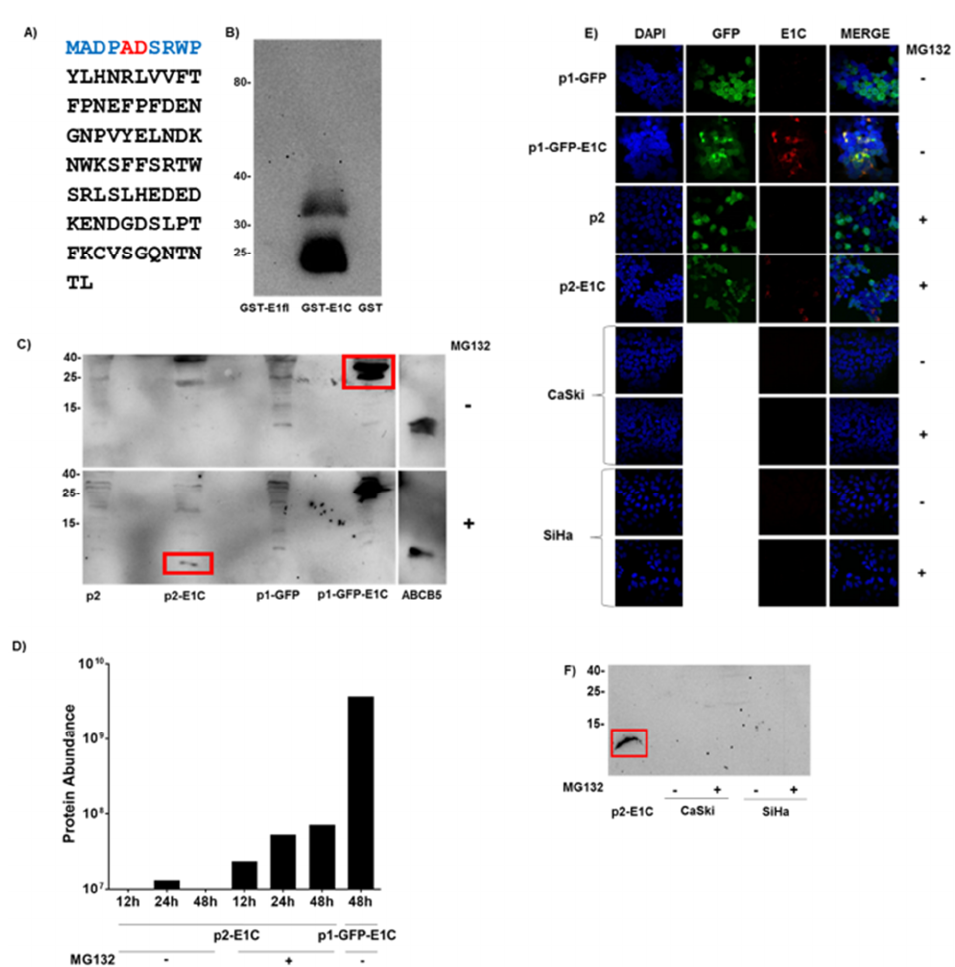
Figure 1. Detection of E1C protein. ( A ) Sequence of the putative E1C protein in black showing the 10 aa E1C-specific peptide used for mouse immunization in blue and the splice junction-derived peptide fusion ‘AD’ in red. ( B ) Reactivity of E1C mAb (hybridoma sub-clone 61/1/2) in Western blot with E. coli lysates overexpressing GST, GST-E1C and GST-E1 full-length (fl) fusion proteins. ( C ) E1C mAb-stained Western blot of lysates (100 µg total protein, prepared 48 h post transfection) from HEK-293T cells transfected with expression plasmids p2, p2-E1C, p1-GFP or p1-GFP-E1C with (bottom) or without (top) proteasome inhibitor MG132 treatment. Size marker (in kDa) is shown on the left and 50 ng of truncated ATP-Binding Cassette sub-family B member 5 (ABCB5)-6XHis protein as positive control for detection of very small pro- teins on the right. Expected positions of E1C and GFP-E1C proteins are marked by red boxes. See supplementary infor- mation (Figure S3) for 12 h and 24 h post transfection results. ( D ) Mass spectrometry analysis of trypsin-digested lysates from HEK-293T cells transfected with p2-E1C or p1-GFP-E1C, harvested 12, 24 and 48 h post transfection with or without MG132 treatment. Y-axis (log 10 scale) shows the combined abundance (protein abundance) of four HPV16 E1C peptides. ( E ) Immunofluorescence reactivity of E1C mAb (hybridoma sub-clone 61/1/2) in HEK-293T cells transfected with p1-GFP or p1-GFP-E1C and E1C immunofluorescence of HEK-293T cells transfected with p2 or p2-E1C as well as HPV16-positive human cervical cancer cell lines CaSki and SiHa with or without MG132 treatment. Nuclei were stained by DAPI (blue), GFP fluorescence (green), E1C mAb fluorescence (red) as well as a merge of all the fluorescence are shown. ( F ) E1C mAb- stained Western blot of lysates (100 µg total protein) from HPV16-positive human cervical cancer cell lines CaSki and SiHa with or without proteasome inhibitor MG132 treatment and, as positive control, from MG132-treated HEK-293T cells transfected with p2-E1C. Expected position of E1C is marked by a red box. See Figure S4 for all the Western blots with the molecular marker.